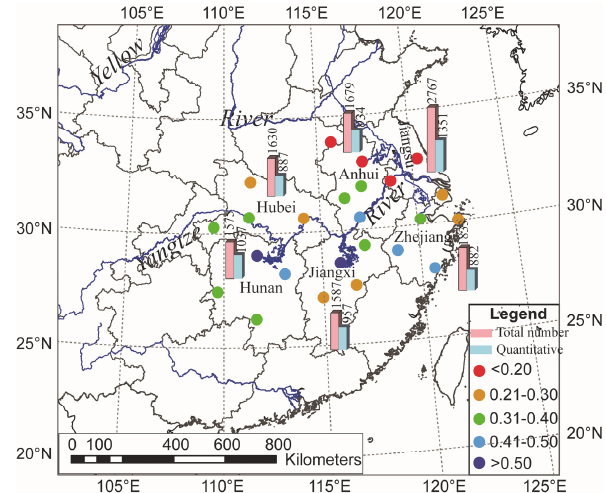
Fig. 1. Locations of stations (dots) used to reconstruct regional win- ter temperature in this study; the bars indicate the numbers of total records and quantitative records; and the colour of the dots indicates the variance in snowfall days explained by the winter